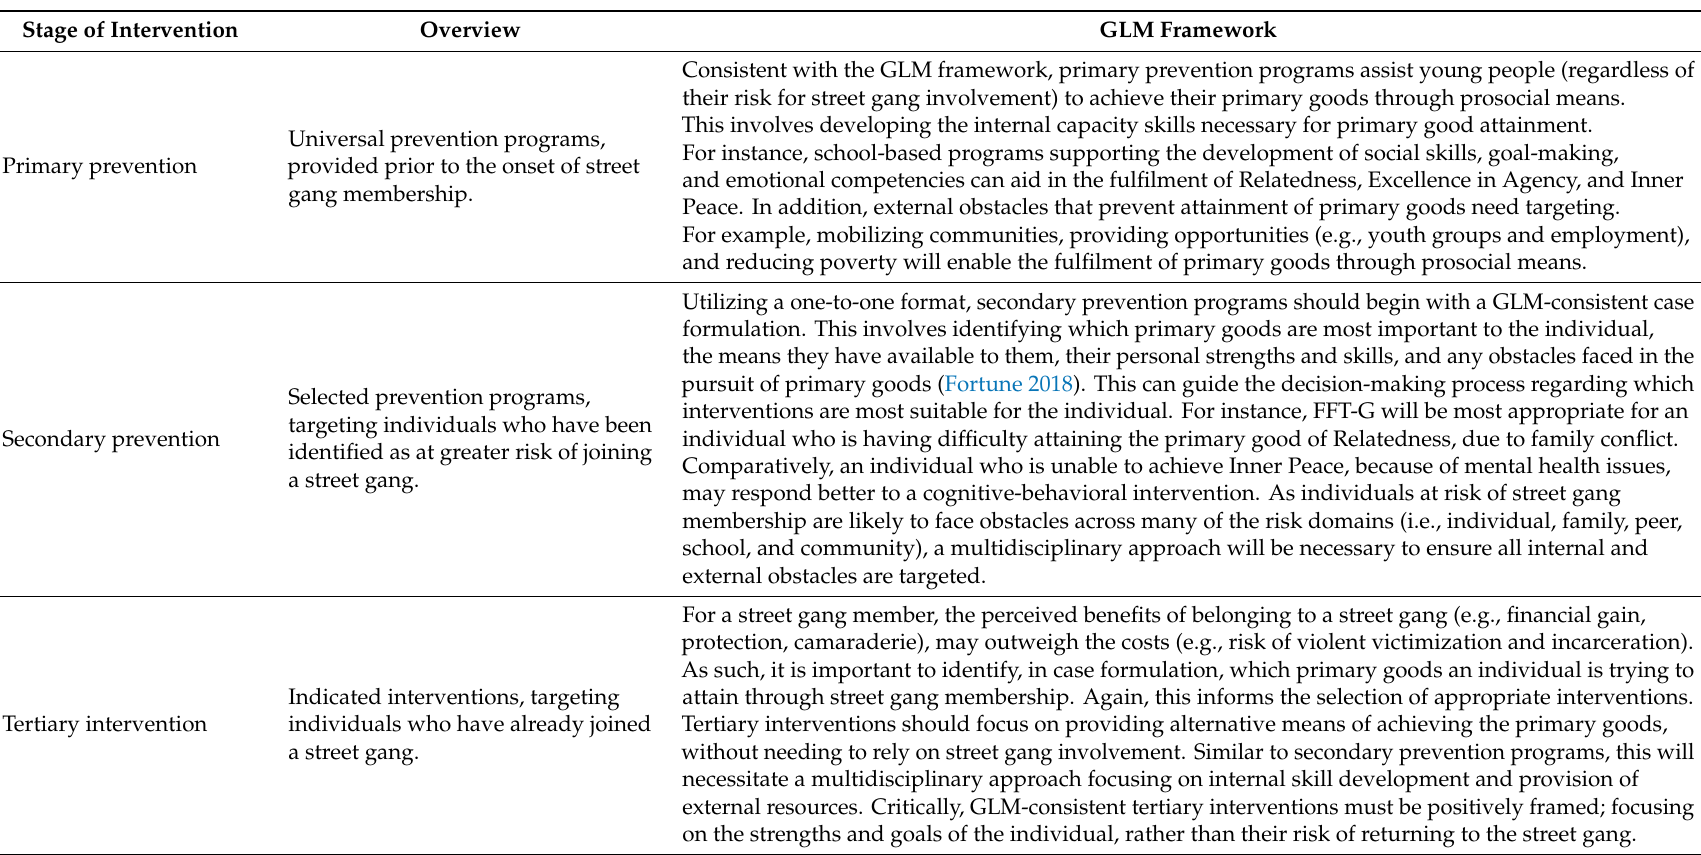
Table 3. Utilizing a Good Lives Model (GLM) framework for Primary, Secondary, and Tertiary Prevention